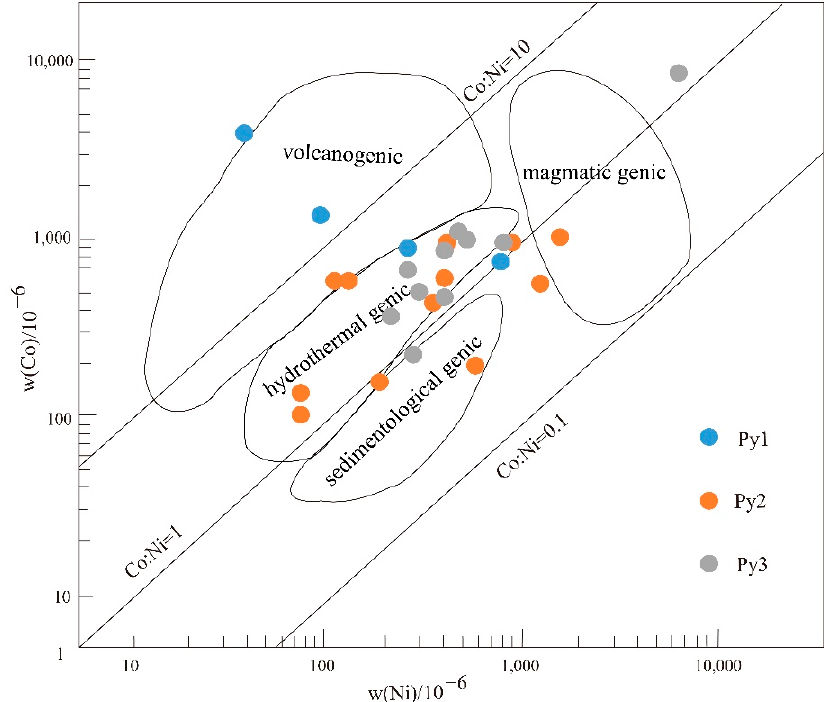
Figure 8. Co/Ni diagram from gold-bearing pyrite (atomic percentage, fitting equation according to [49]).